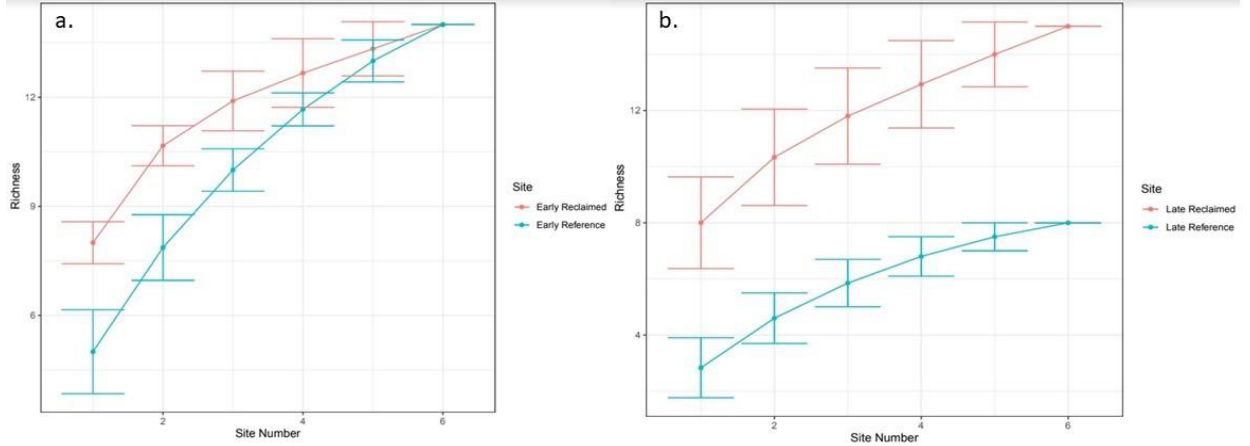
Figure 3. Accumulation curves with Family Richness on the y -axis and Site Number on the x-axis for Early Season ( a ) and Late Season ( b ).